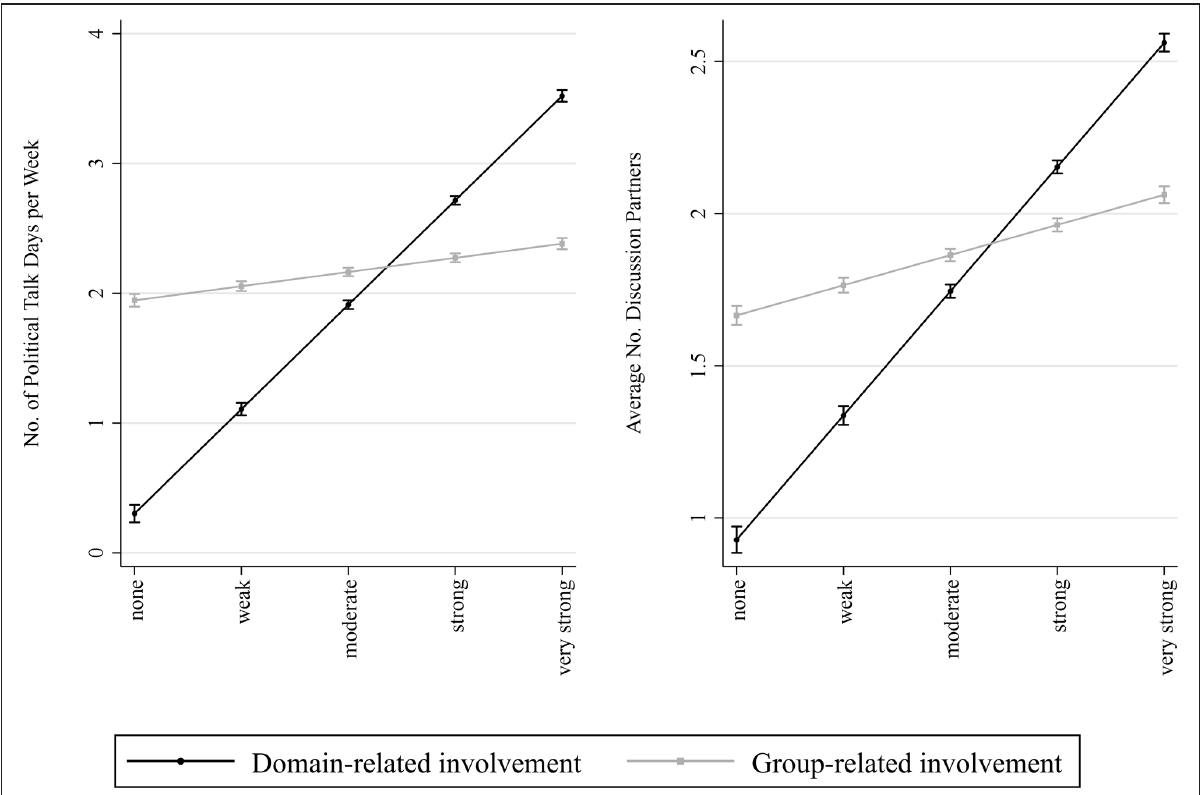
Figure 3: Predicted discussion frequency and discussion network size by levels of political involvement. Note: Probabilities are predictions for men of average education and age; Source: ZA6804, Version